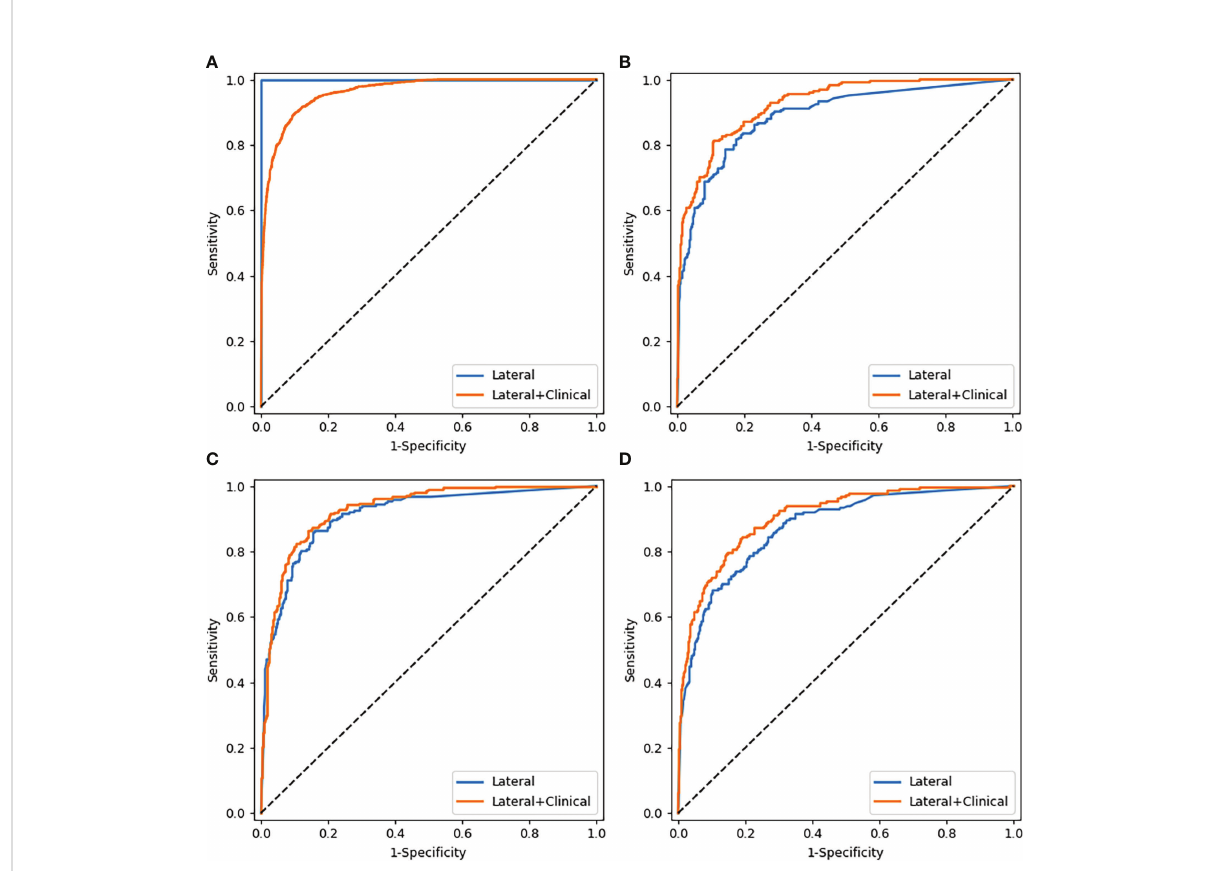
FIGURE 4 Comparison of ROC curves of the CNN models based on lateral images with and without combining clinical parameters. (A – D) were the curves of the training cohort, validation cohort, test cohort 1, and test cohort 2,